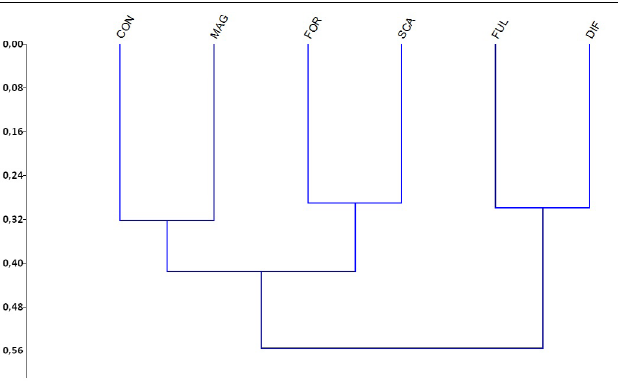
Figure 1: Results of a UPGMA analysis of a log sem matrix based on anatomical measurements of six species of Galápagos ground finches, namely Geospiza magnirostris (MAG), G. fortis (FOR), G. fulginosa (FUL), G. difficilis (DIF), G. conirostris (CON) and G. scandens (SCA). The phenetic tree corresponds closely with a phylogeny presented by Burns et al. 9 and Reaney et al., 10 based on genetic data. Measurements were obtained from the California Academy of